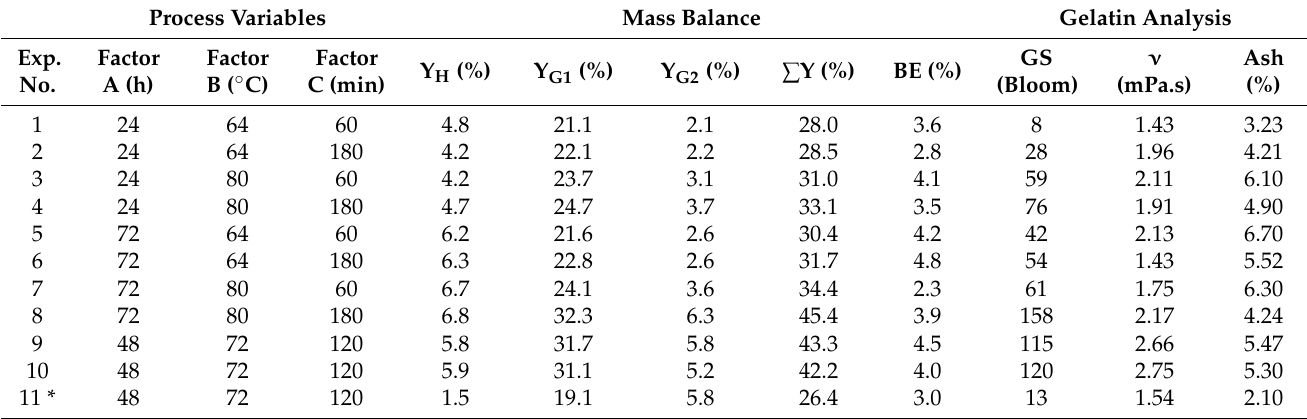
Table 1. The schedule of experiments and the results of processing of MDCM by-product into gelatins. Process Variables Mass